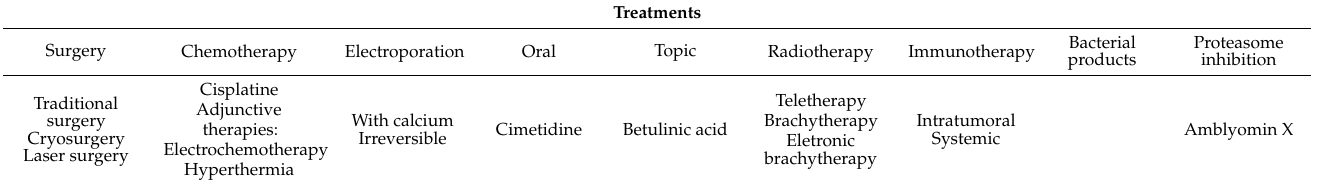
Table 3. Generic compilation of treatment modalities currently used in equine melanocytic tumors. Treatments